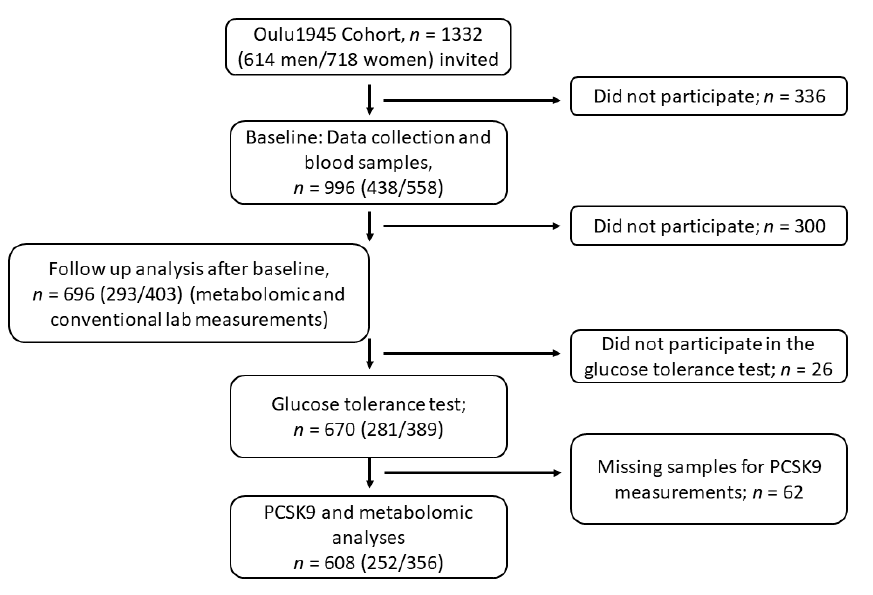
Figure 1. Flow chart of the study. PCSK9 (Proprotein convertase subtilisin/kexin type 9).